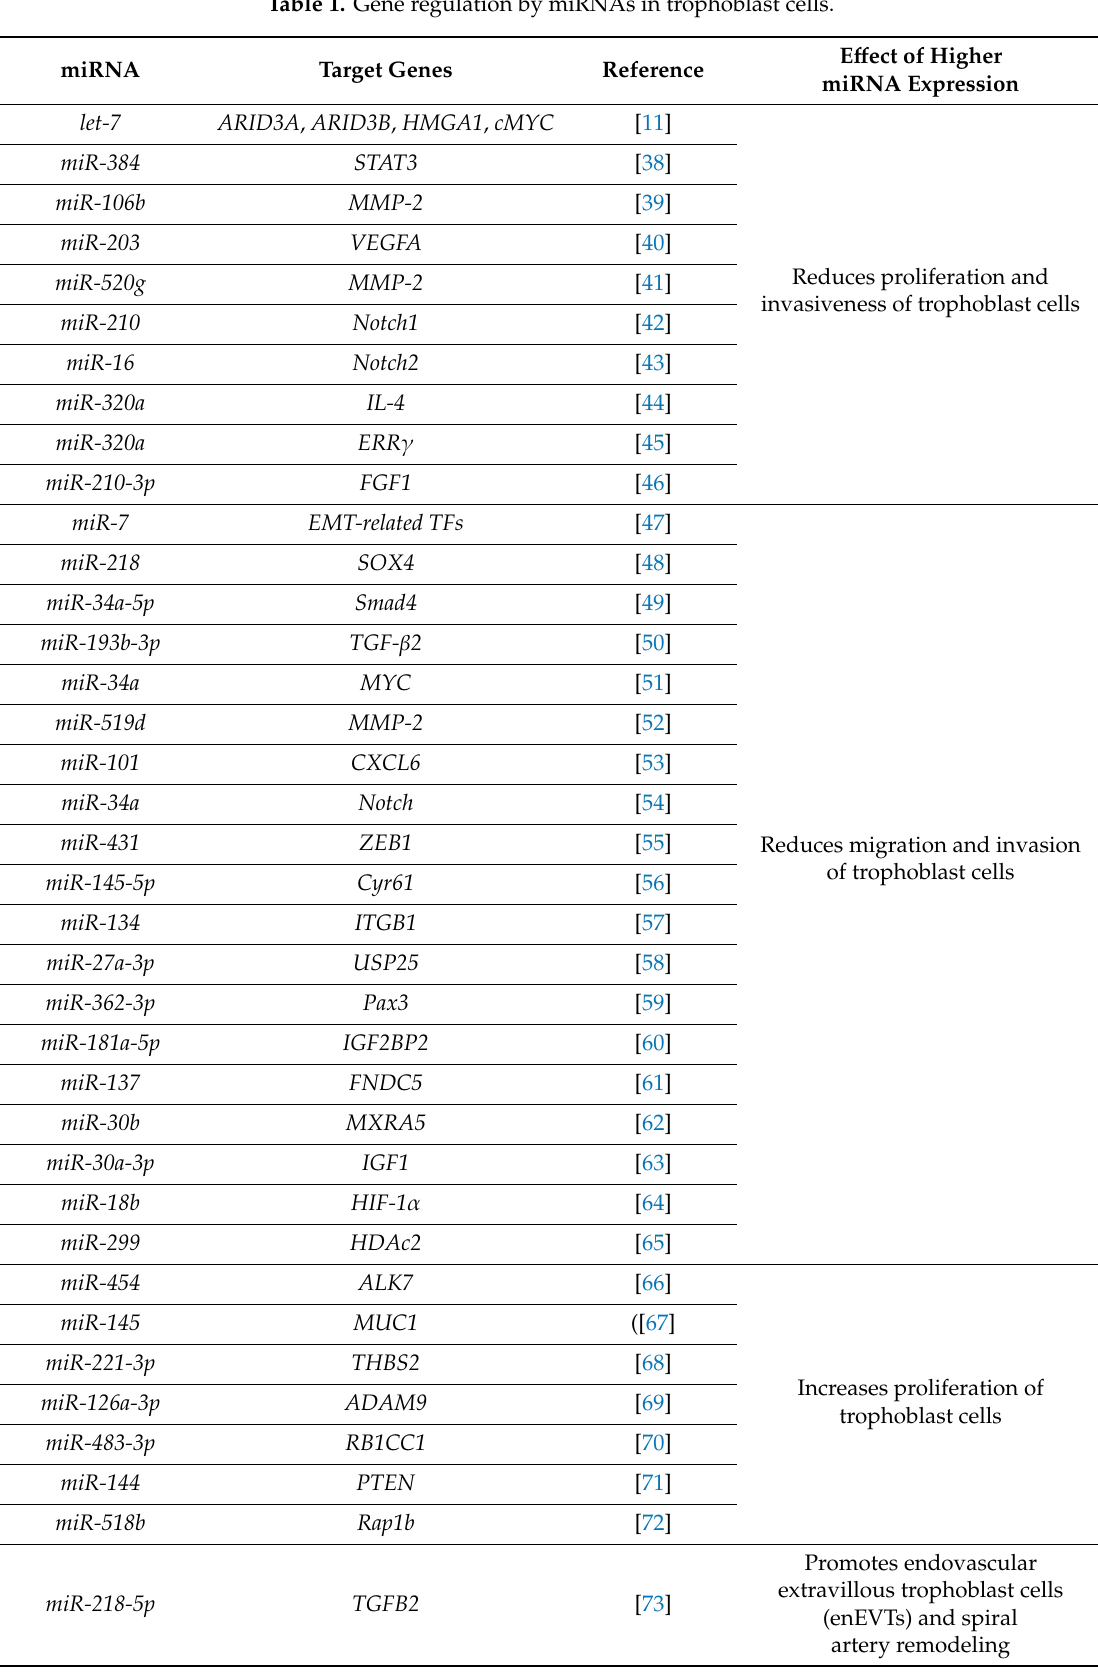
Table 1. Gene regulation by miRNAs in trophoblast